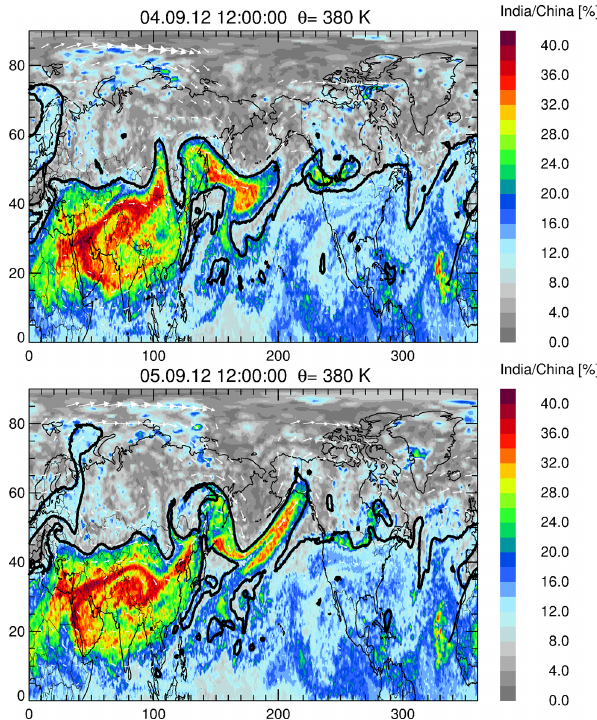
Figure 2. Horizontal distribution of the fraction of air originating in India/China (here the sum of emissions from northern India, south- ern India, and eastern China) at 380K potential temperature on 4 (top) and 5 (bottom) September 2012. The horizontal winds are in- dicated by white arrows. The 7.2PVU surface is shown as a thick black line, indicating the climatological isentropic transport barrier at 380K in September (Kunz et al.,